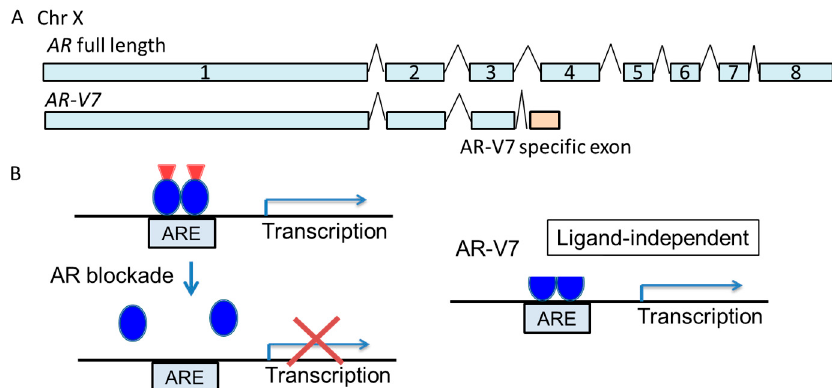
Figure 1. Genomic structure and transcriptional regulation by androgen receptor-variant 7 (AR-V7). A. A schematic of the genomic structure of the androgen receptor (AR) gene (exons 1–8) and the splicing variant, AR-V7 . B. The AR-V7 protein lacks the ligand-binding domain of AR. Therefore, AR blockade by anti-AR drugs is not e ff ective for tumors expressing AR-V7, because AR-V7 exerts ligand-independent transcriptional activity. ARE: androgen response